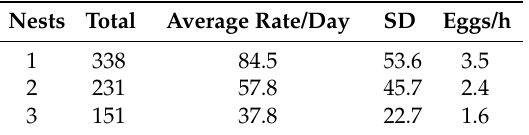
Table 1. Total number of eggs, average oviposition rate (per day) in 96 h and standard deviation (SD), and eggs/h rate of the queens from three laboratory colonies of Acromyrmex rugosus rugosus. Temperature: 24 °C. Humidity: 70%.